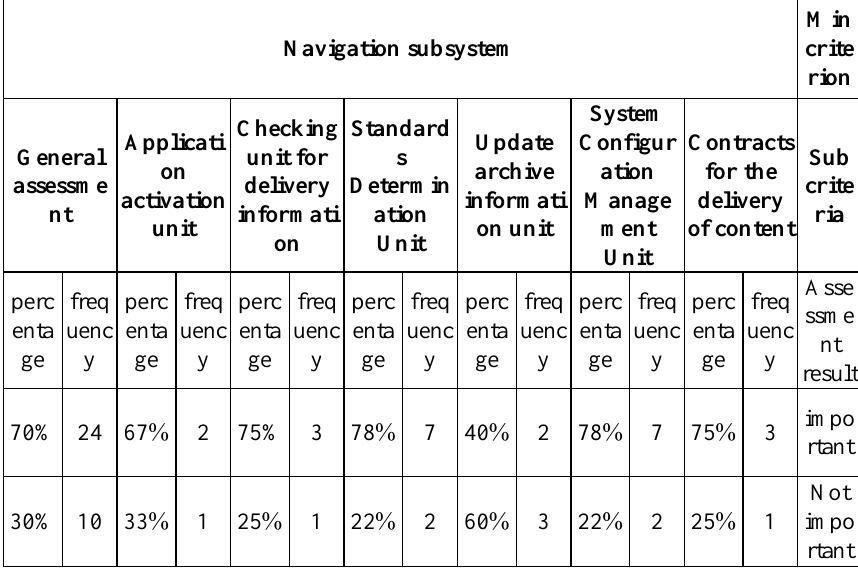
Min crite rion System Contracts Configur Sub for the ation crite delivery ria of content